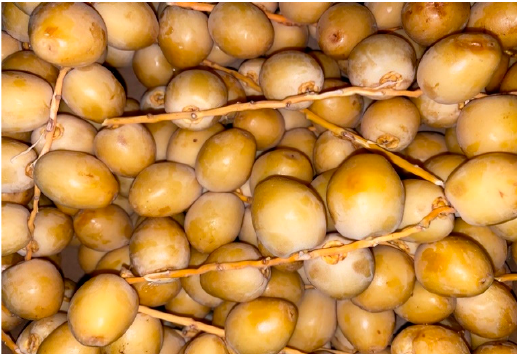
Figure 8. Sample of Al-barhi dates.